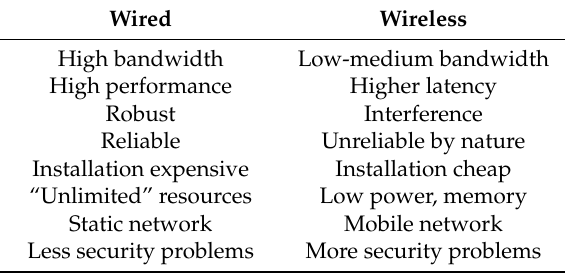
Table 1. Differences between the wired and wireless communication protocols